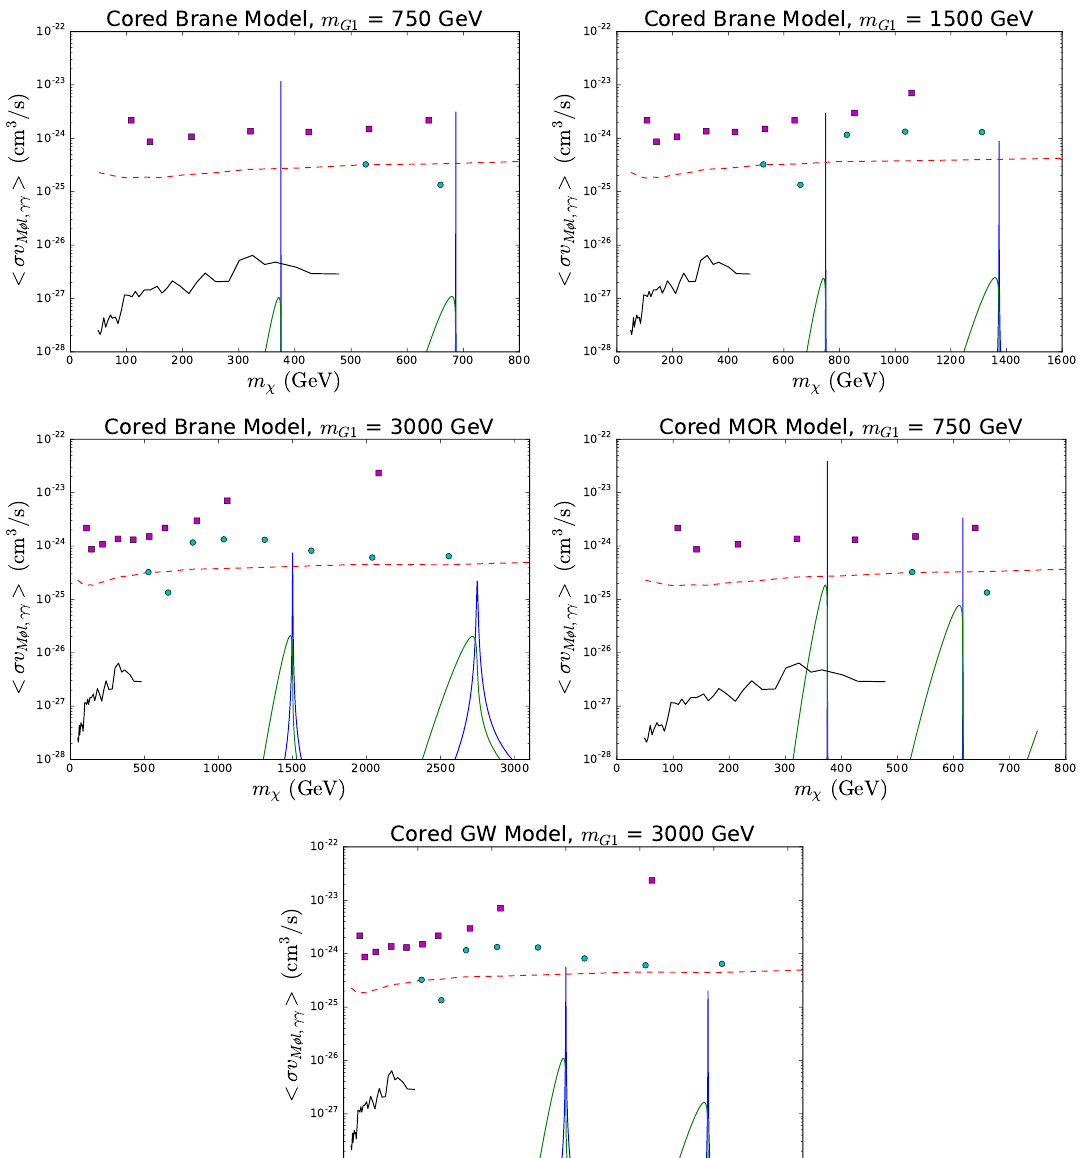
Figure 7 . Assuming a cored pro(cid:12)le, the thermally averaged dark matter annihilation cross section into two photons at z = 0 (at thermal freeze-out) for spin-1 dark matter as a function of the DM mass is given by the blue (green) curve for the 5 benchmark models as labeled. The photon line search limits from FERMI (solid black), HESS I (cyan circles), and HESS II (magenta squares) are also shown, as well as the projected sensitivity of the Cerenkov Telescope Array (red-dashed line).